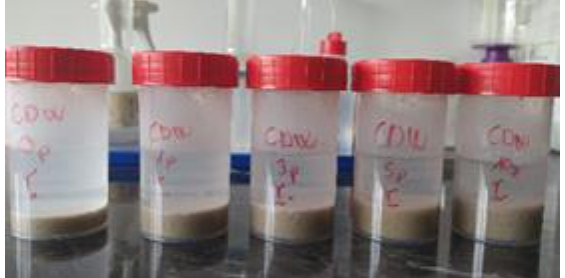
Figure 2. CDW samples after the lime sorption test (from left to right: 0 min, 1 min, 3 min, 5 min and 10 min).